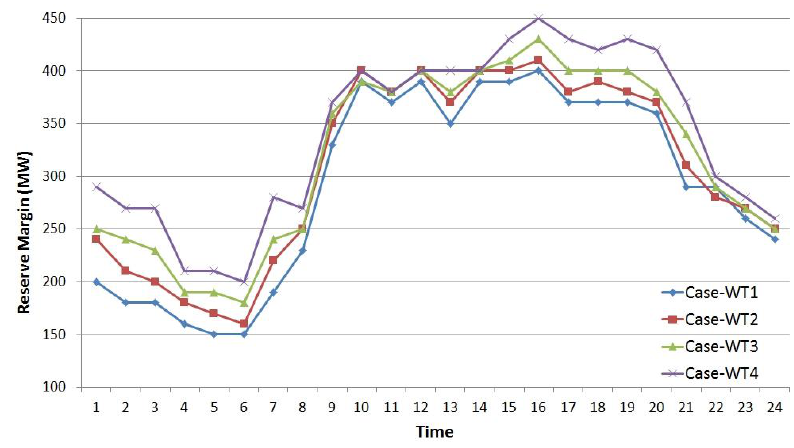
Figure 7. Hourly reserve margin of case-WT1, Case-WT2, Case-WT3, and Case-WT4.